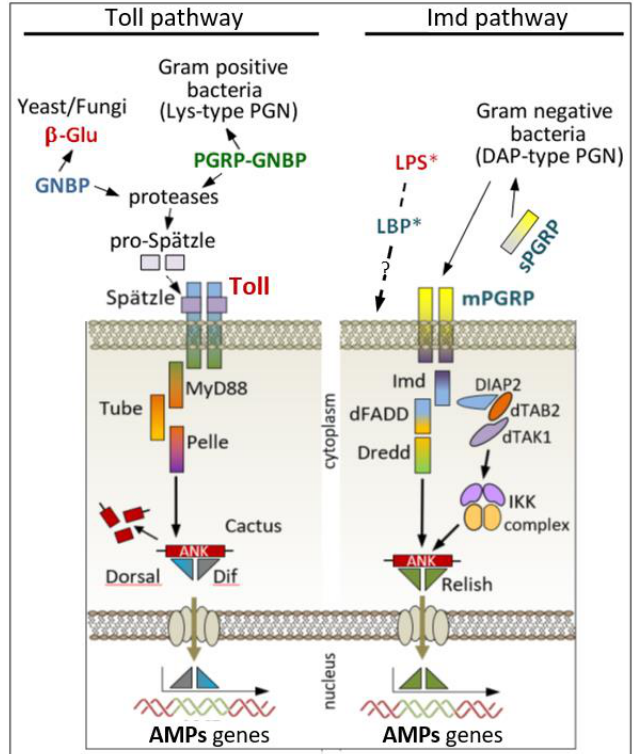
Figure 4. Cellular PRRs: Toll and Imd pathways. ( Left ) a schematic view of fungine and Gram-positive bacteria stimulation of Toll pathway; the intracellular signal transduction involves adaptor proteins as MyD88, Tube and the serine/threonine protein kinase Pelle. Upon activation, Toll receptor-adaptor complex signals to a latent transcriptional factor, belonging to the NF-kB-Rel family, NF-kB factor is normally complexed to an inhibitor protein (IkB-like) named Cactus. The Toll signaling induces the degradation of Cactus and dissociation from Rel family proteins (Dorsal and Dif). Dif, a member of NF-kB-like proteins, seems to be the main transactivator factor responsible for antifungal and anti-Gram positive bacterial defenses. Dif translocates into the nucleus and switches on many AMPs (antimicrobial peptides) genes, probably several hundred, that in concert contribute to challenge microbial infection. ( Right ) the Imd pathway stimulated by Gram negative bacteria. The Imd gene encodes a 25 kDa protein with a death domain , the protein acts upstream of an adaptor protein named FADD; furthermore, for a full activation, a caspase-8 like protein is required (Dredd). Dredd can directly activate REL protein (Relish). Finally, Rel domain after cleavage, moves to the nucleus and activates AMPs genes. Otherwise, Relish can be phosphorylated by IKK signaling complex, which is itself activated by Tak1 (a MAP kinase) interacting downstream of Imd /FADD.